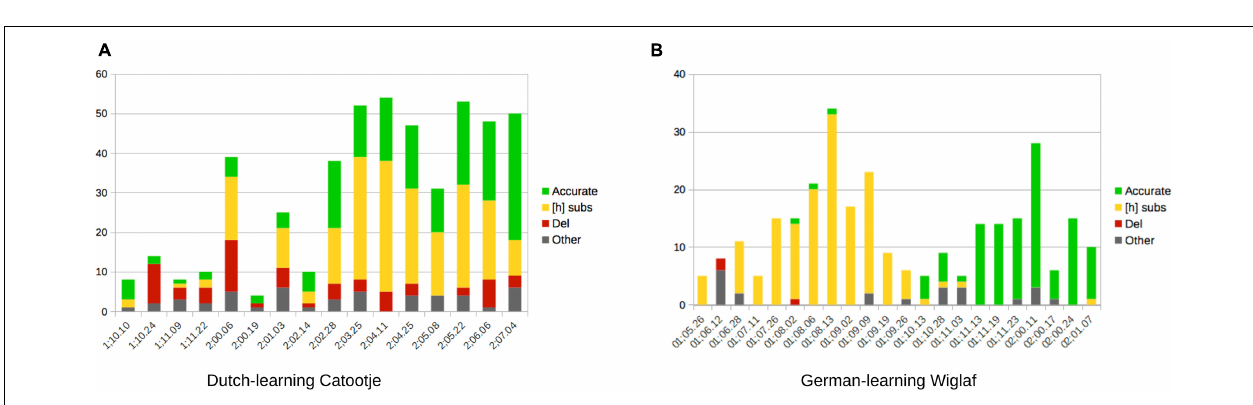
FIGURE 2 | Illustrations of [h] substitution vs. | ö | deletion. (A) <gi>raffe | " R af @ | → [ " haf @ ]. (B) regarde | R @" g A R d| → [o " ga].